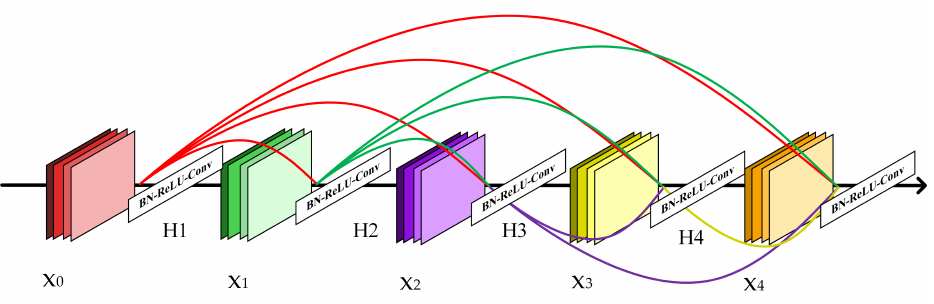
Figure 1. The structure of